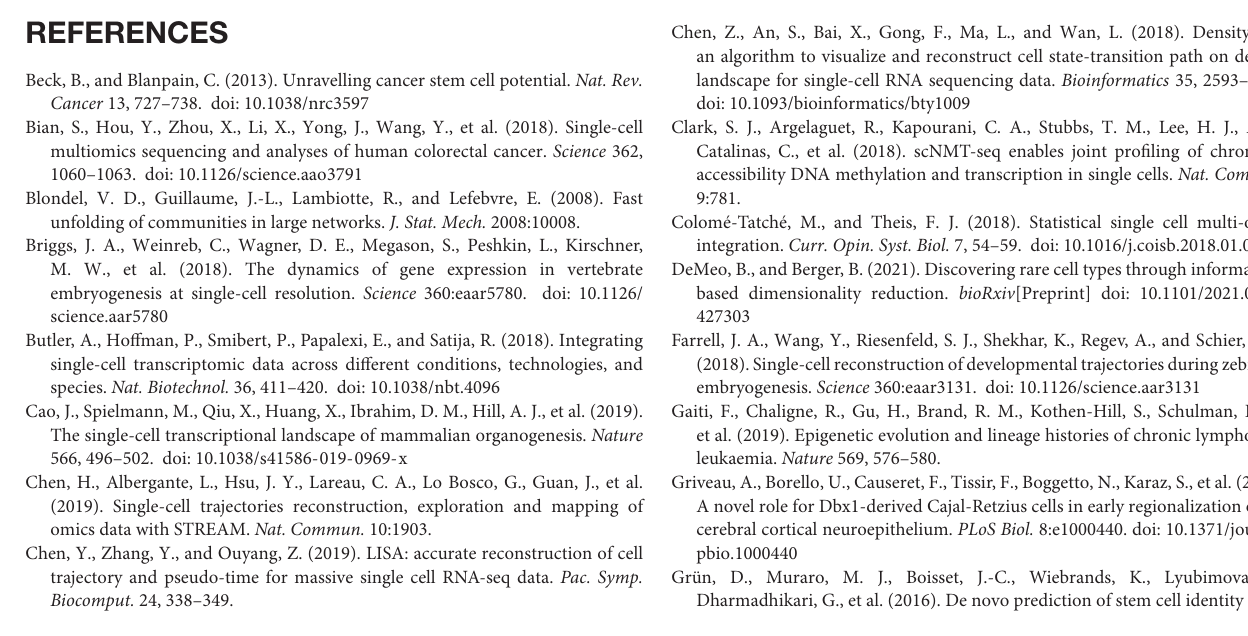
are corresponding to the rank 1 to 3. Prethalamic neuros (pTh.N), rostral thalamic neurons (rTh.N), zona limitans intrathalamica (ZLI), epithalamic neuros (ETh.N),